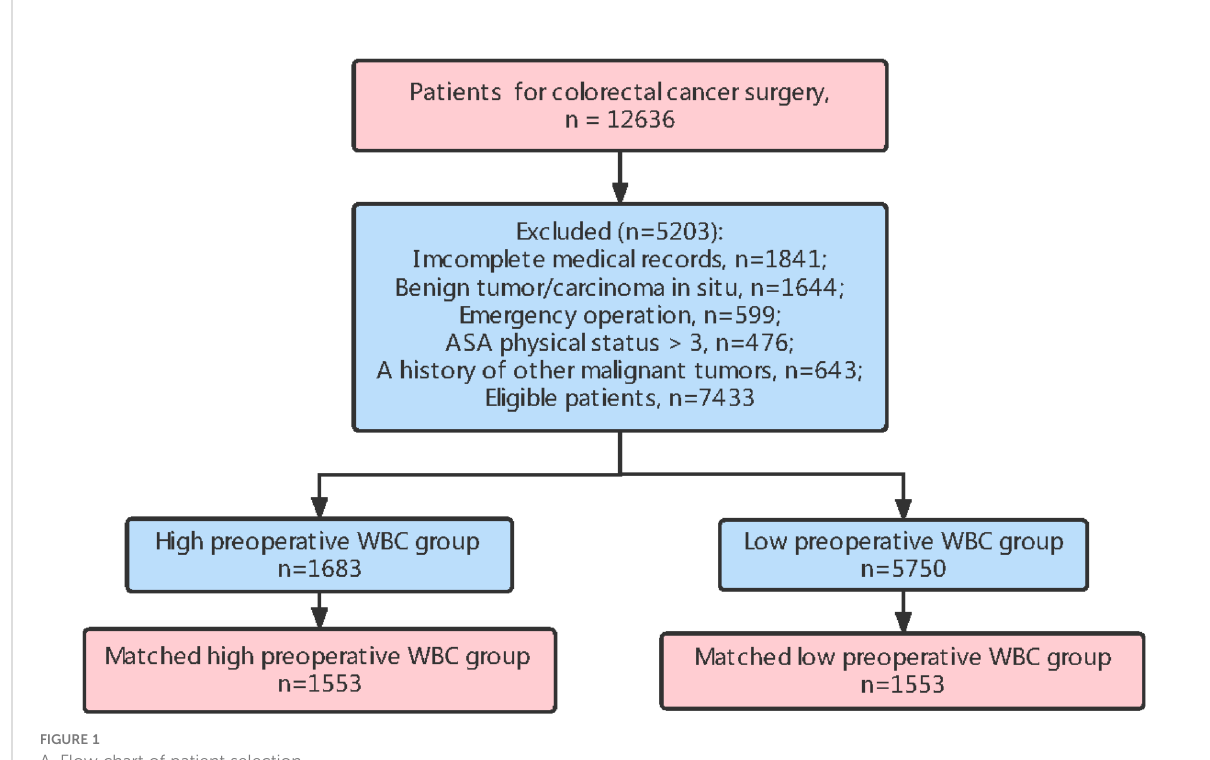
FIGURE 1 A. Flow chart of patient